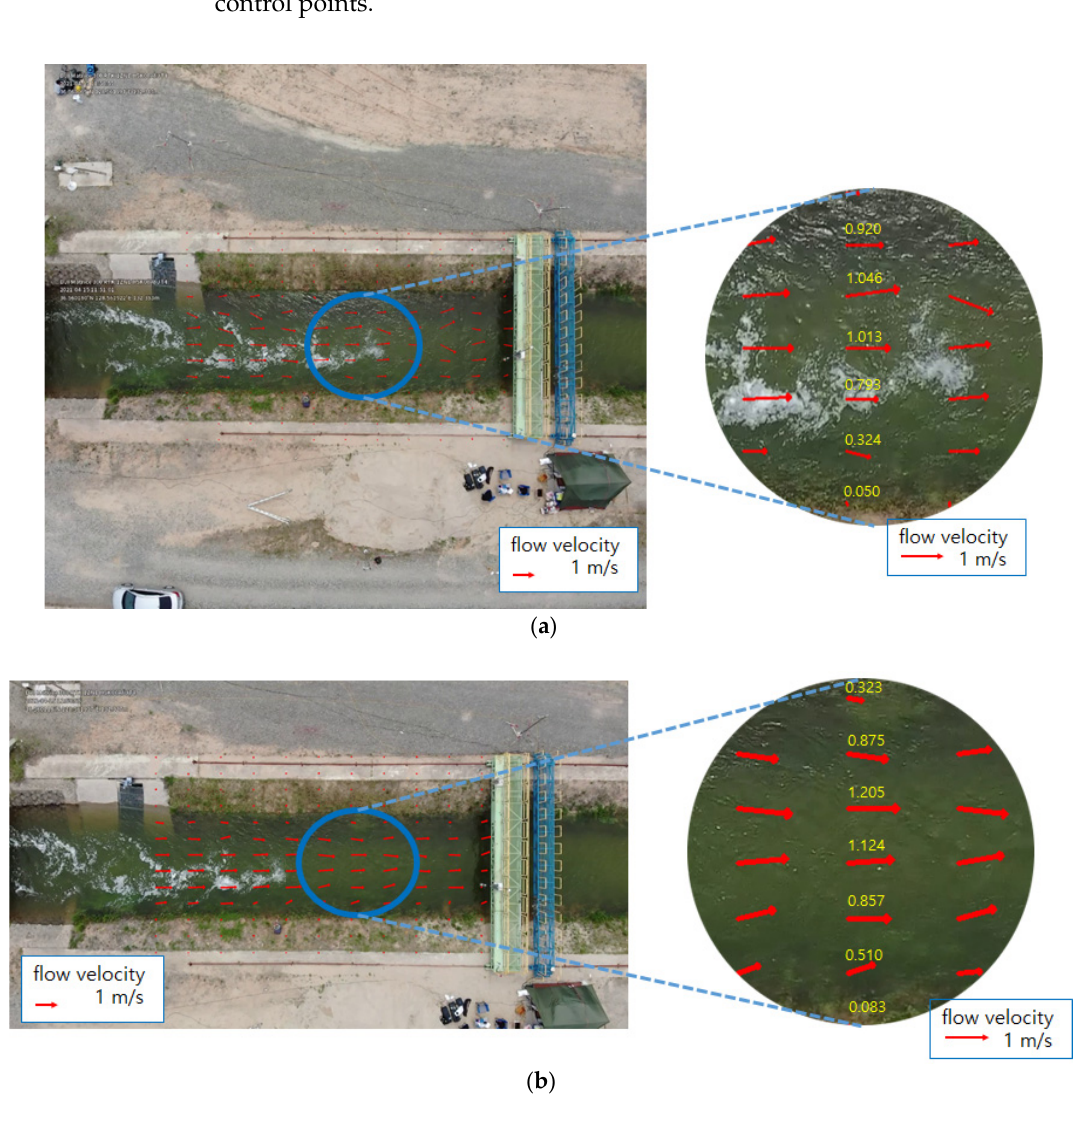
Figure 6. Velocity fields measured using the drone images. ( a ) Moving drone method; ( b ) Hovering drone method. (the numbers representing flow velocity were added later for reference ).